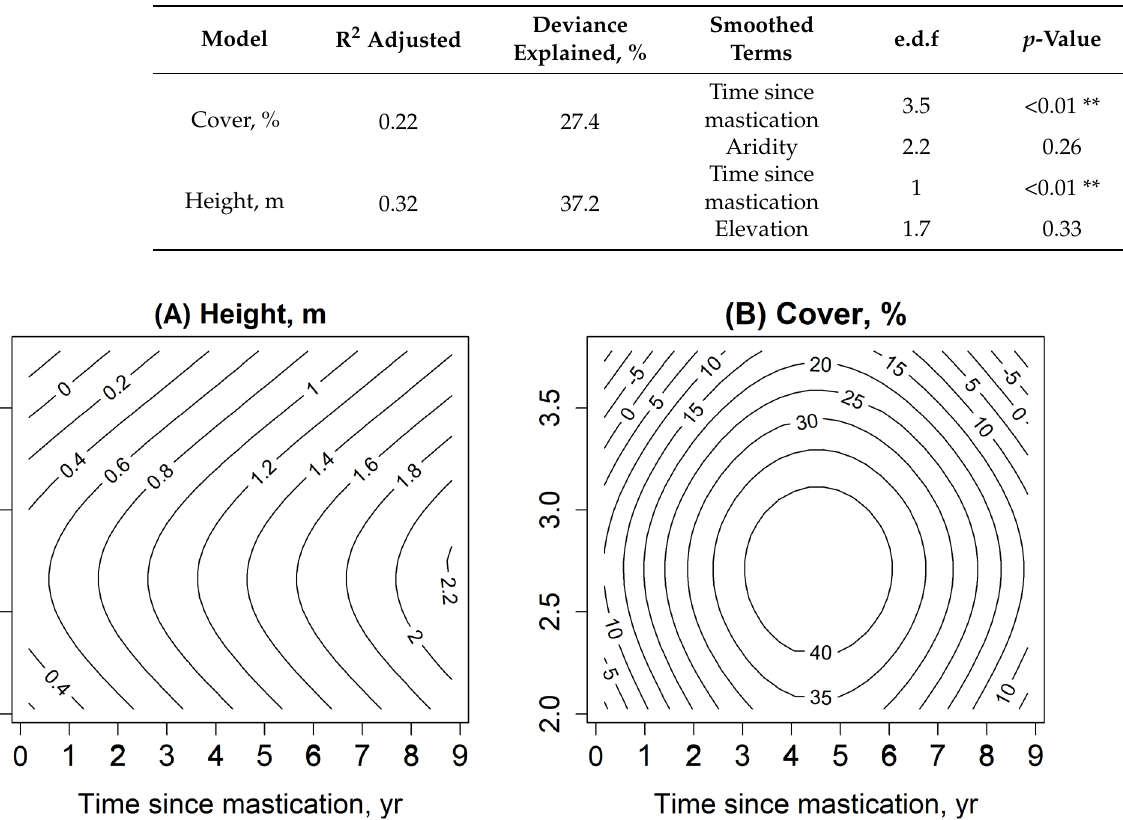
Figure 4. Smoothed lines (GAMs) to show variation in mean standing fuel cover as a function of vegetation height for different timeframes post-mastication. Grey dashed line represents untreated sites experiencing shrub encroachment measured by Grant, Duff [12]. Dots represent raw data from this study and do not include untreated site data. Table 3. Diagnostics of the GAMs fitted to the standing fuel properties with time since mastication and aridity as smoothed predictor variables. e.d.f. = effective degrees of freedom. Statistical significance denoted by ** p < 0.01.